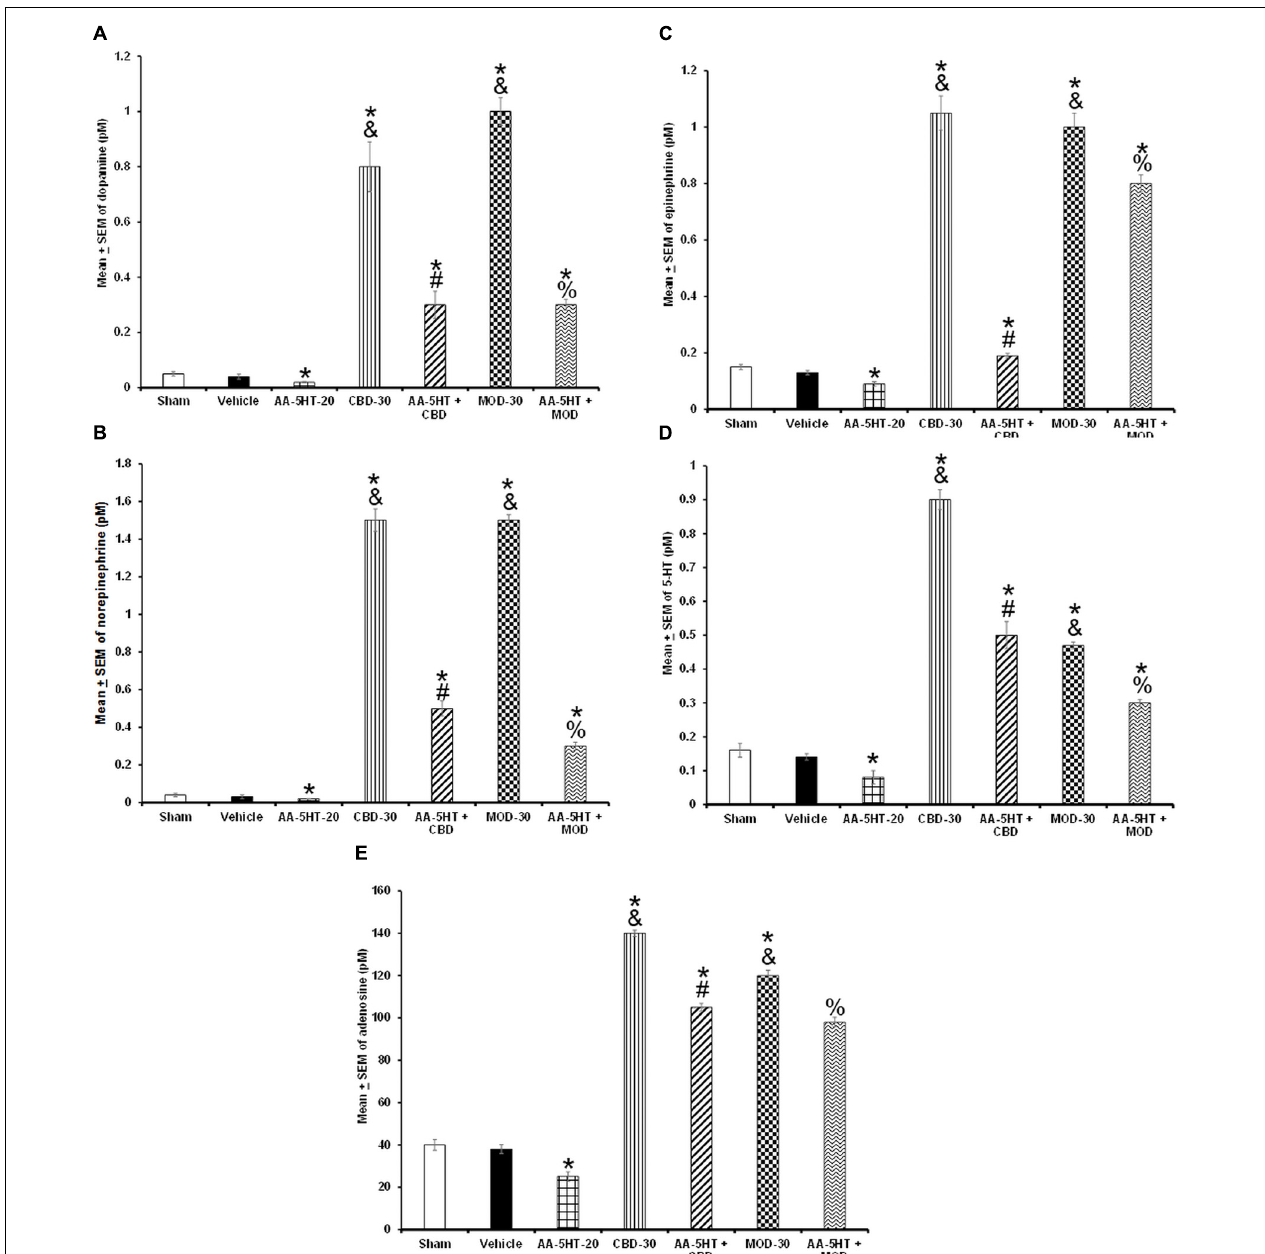
FIGURE 12 | Effects of experimental trials: Sham, vehicle, AA-5-HT (20 mg/Kg; i.p.), cannabidiol (CBD; 30 mg/Kg; i.p.), AA-5-HT (20 mg/Kg; i.p.) and 15 min later CBD (30 mg/Kg; i.p.), modafinil (MOD; 30 mg/Kg; i.p.) or AA-5-HT (20 mg/Kg; i.p.) and 15 min later MOD (30 mg/Kg; i.p.) during the sleep rebound period in sleep-deprived rats on extracellular levels of DA, NE, EP, 5-HT, and AD. AA-5-HT decreased extracellular levels of all neurotransmitters studied. Moreover, injection of either CBD or MOD increased the contents of DA, NE, EP, 5-HT and AD ( A–E , respectively) during the sleep rebound period. Importantly, combination of AA-5-HT + CBD partially prevented the CBD-induced changes in neurotransmitters. Similar results were observed in AA-5-HT + MOD-treated rats compared to MOD-injected animals (Mean ± SEM ∗ vs. Sham/Vehicle, P < 0.05; & vs. AA-5-HT-20, P < 0.05; # vs. CBD-30, P < 0.05; % vs. MOD-30, P < 0.05). Abbreviations: Cannabidiol 30 mg/Kg, i.p. (CBD-30), modafinil 30 mg/Kg, i.p. (MOD-30), AA-5-HT-20 mg/Kg